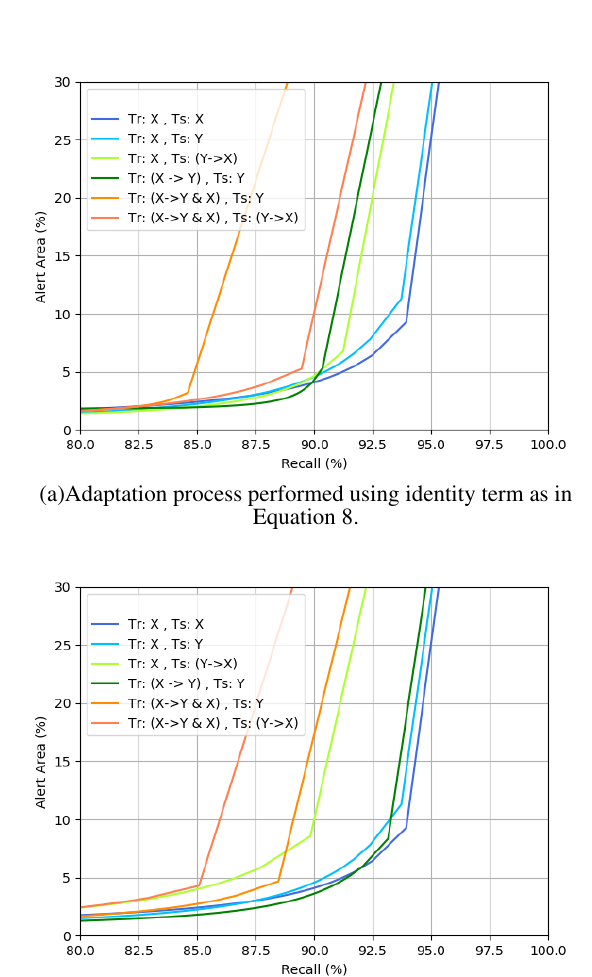
(b)Adaptation process performed using identity term as in Equation 9. Figure 6. Recall vs Alert